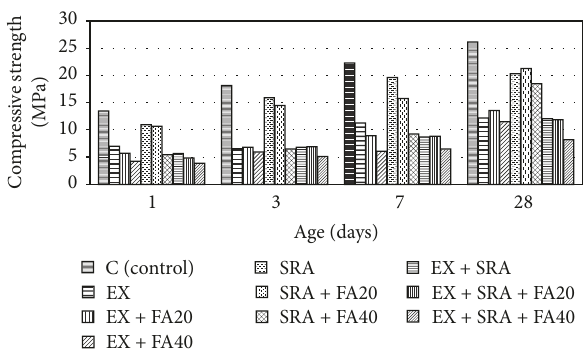
Figure 4: Compressive strength of normal-cured